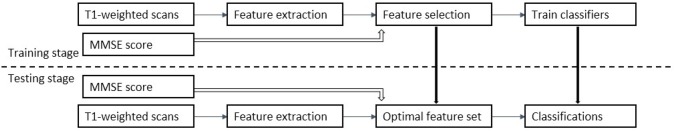
Overview of the classification procedure using T1-weighted scans and the MMSE score [32].